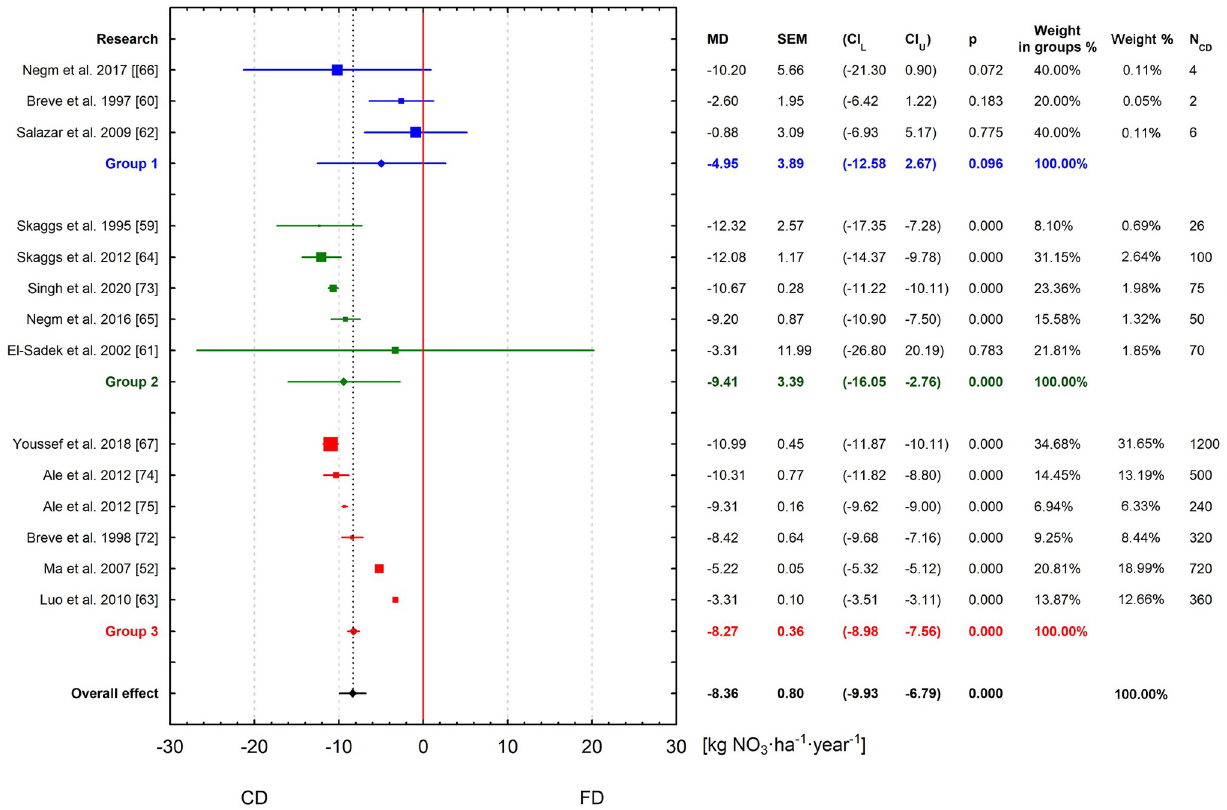
Fig 7. Meta-analysis in groups of nitrate load in drainage outflow by CD versus